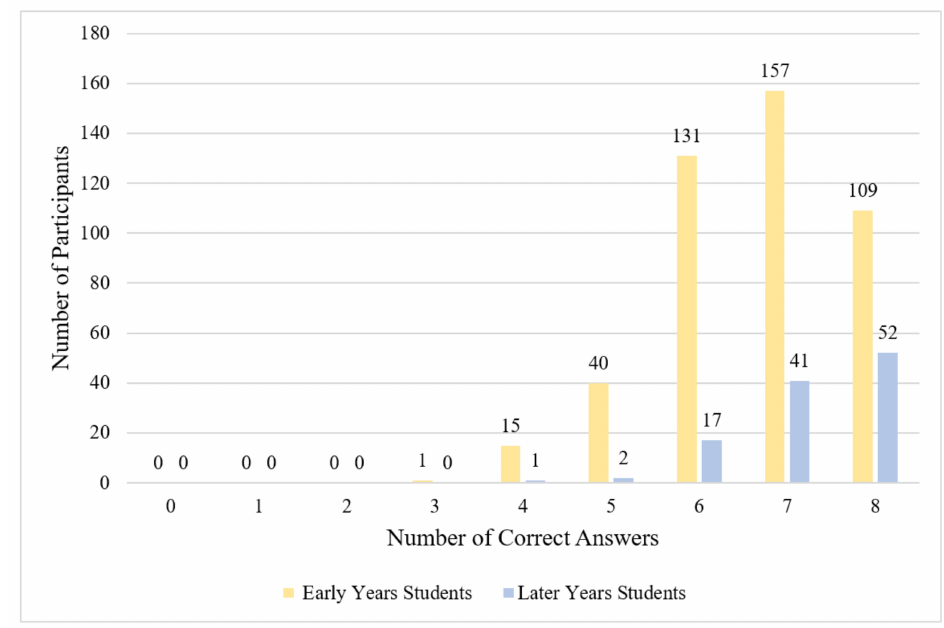
Figure 1. Frequency of knowledge scores (early years, n = 453; later years n =